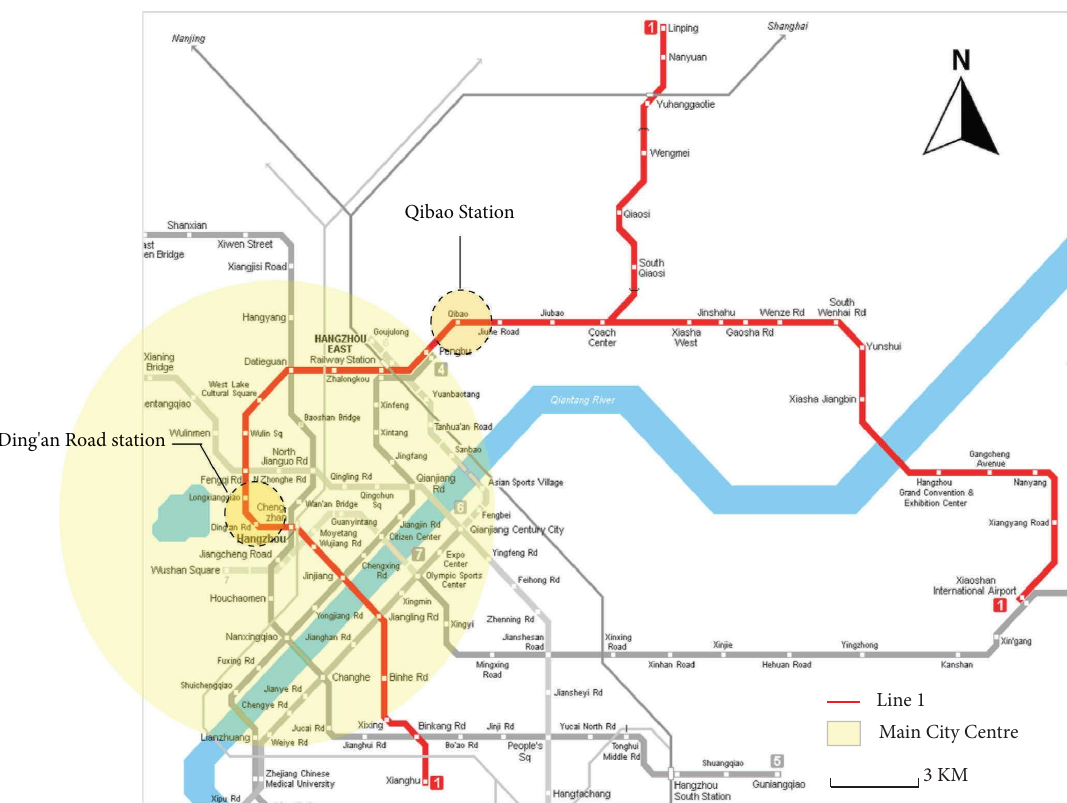
Figure 1: Hangzhou’s metro